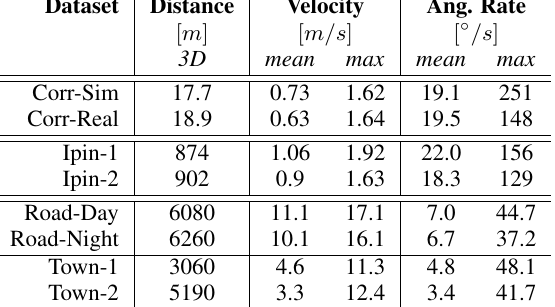
Table 2. Camera motion characteristics for the different datasets.